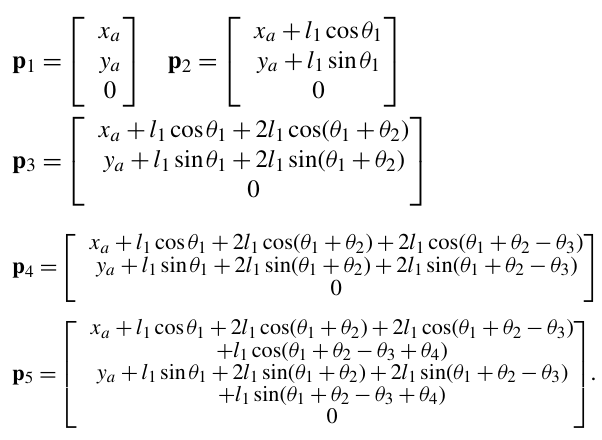
the viewpoint of kinematics. All the achievements with SLEs were mainly focused on deployable